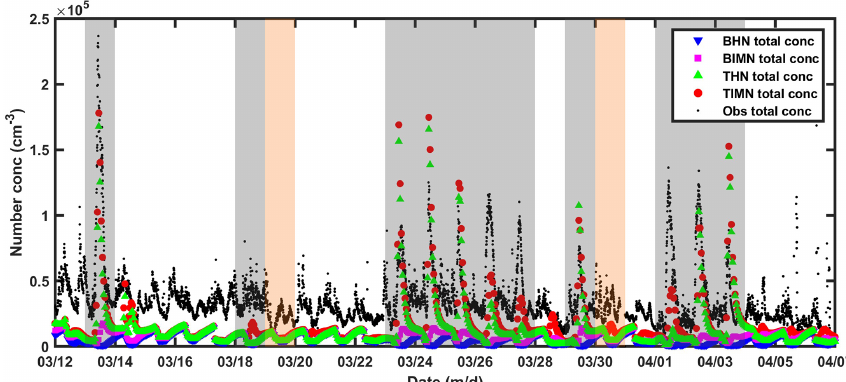
Figure 5. Comparison of observed total particle number concentrations with those simulated on the basis of BHN, BIMN, THN, and TIMN schemes during the measurement period. The identified NPF days and undefined days are shaded with a grey and orange background, respectively.